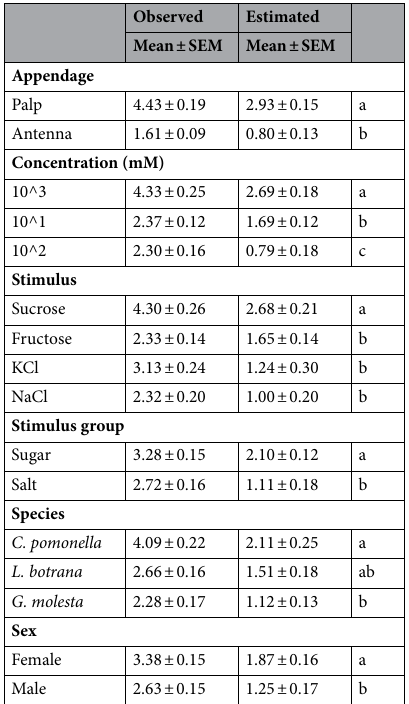
Table 3. Pairwise comparison of the number of spikes produced by sensilla chaetica present on the antennae and labial palps of the three moth species. Observed data and estimated values from the GLM model are presented. Letters in the right column indicate significant differences among the levels of each factor (Tukey ́ s test, p < 0.05 after